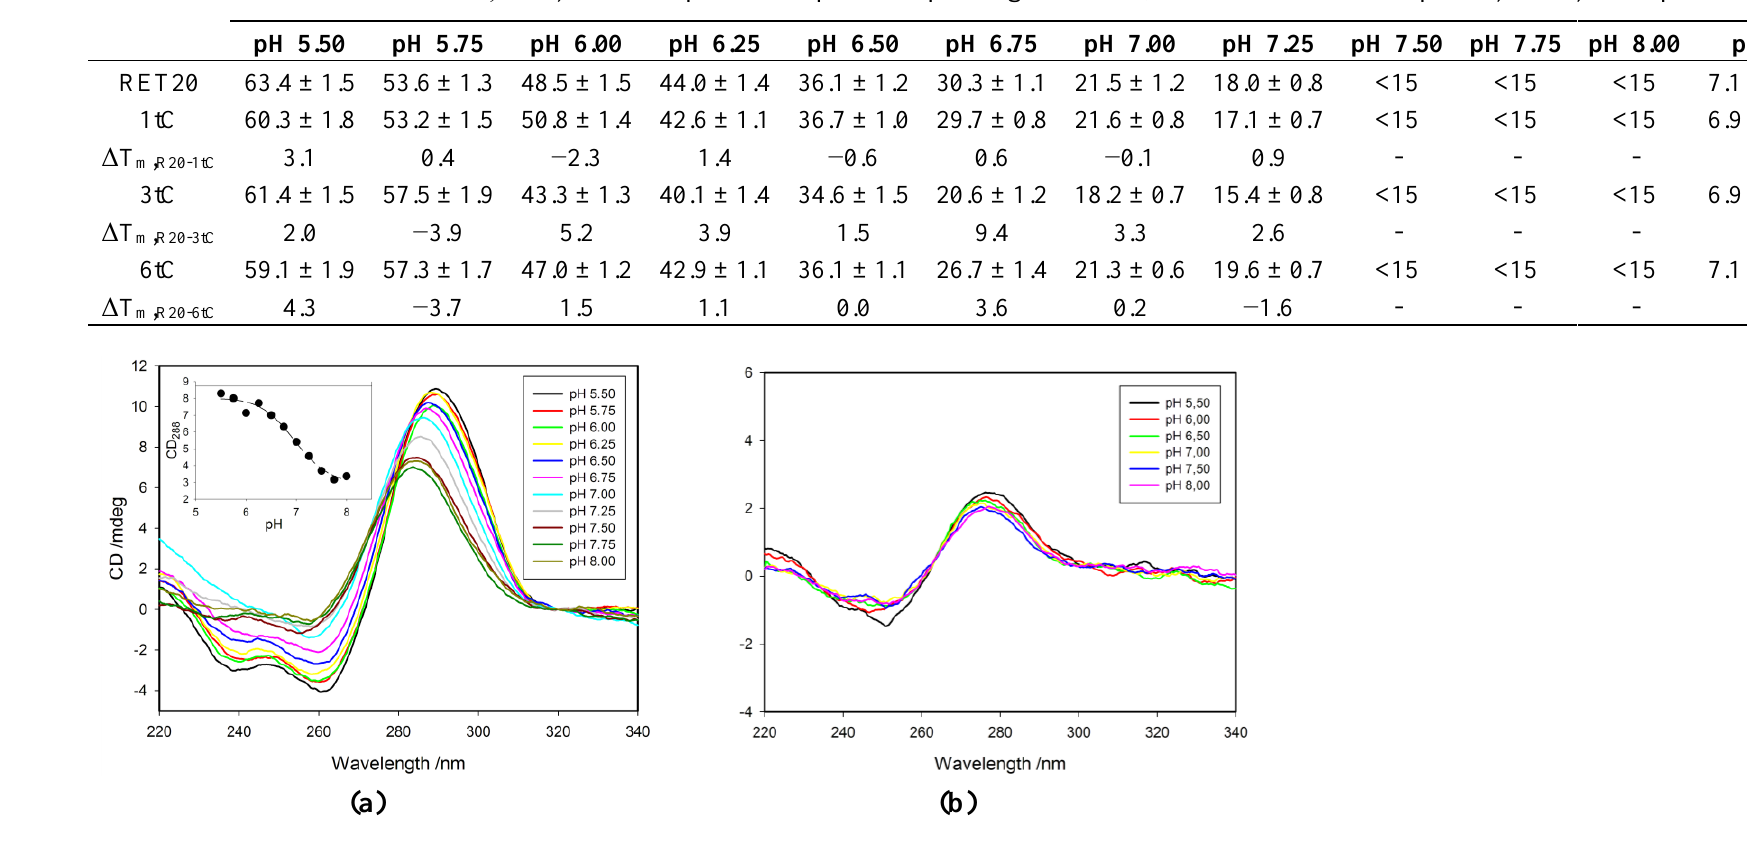
Figure 3. ( a ) CD spectra of 1tC probe in the pH range of 5.50–8.00. Insert: the dependence of CD signal at 288 nm against the pH values. The pH T values for this and other probes are shown in Table 2. ( b ) CD spectra of TtC probe at different